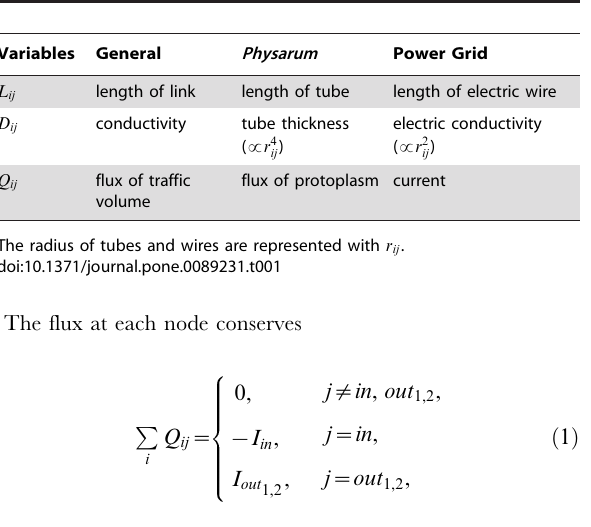
Table 1. Correspondence of